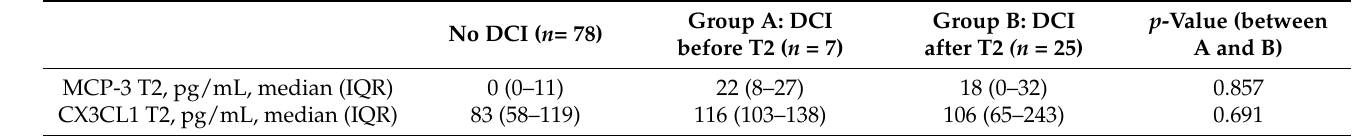
Table 3. Association of MCP-3 and CX3CL1 levels measured at T2 with the time of DCI detection.